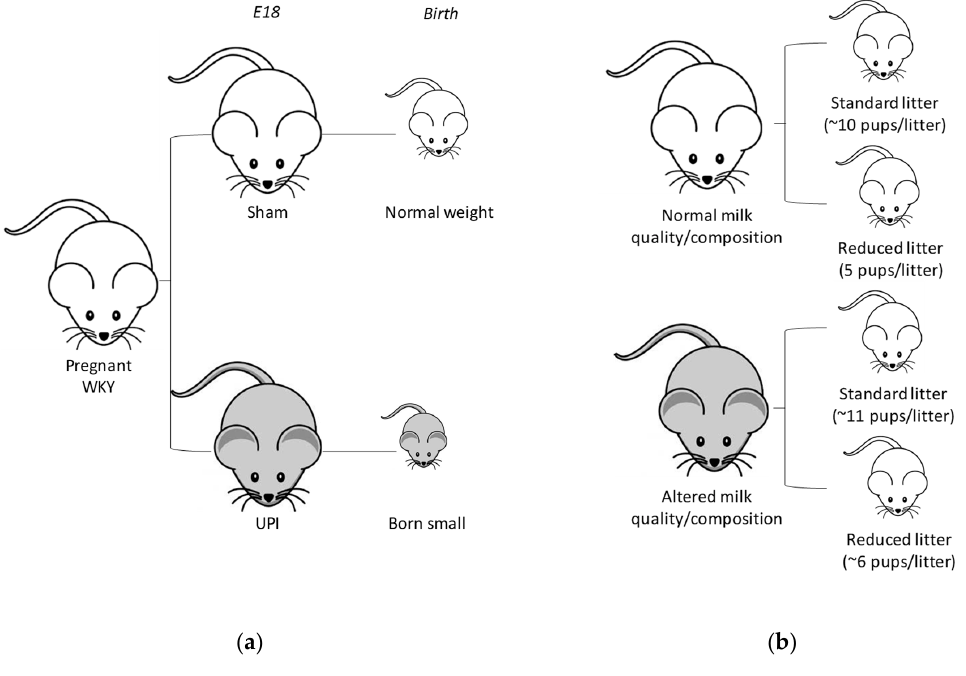
Figure 1. Study design. ( a ) Pregnant Wistar Kyoto (WKY) rats underwent Sham (white) or uteroplacental insufficiency (UPI; grey) surgery on day 18 of gestation (E18) and allowed to deliver naturally at birth. ( b ) On postnatal day 1 (PN1) pups from the Sham surgery dams were cross-fostered onto separate Sham (with Normal milk quality/composition) or UPI (with Altered milk quality/composition) dams with either an intact or reduced litter size.